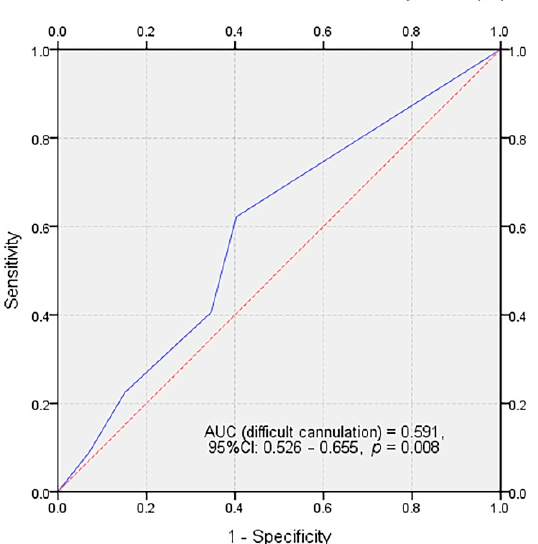
Figure 3. Receiver operating characteristic (ROC) curve for evaluating the predictive power of different papilla types on the rate of difficult cannulation.